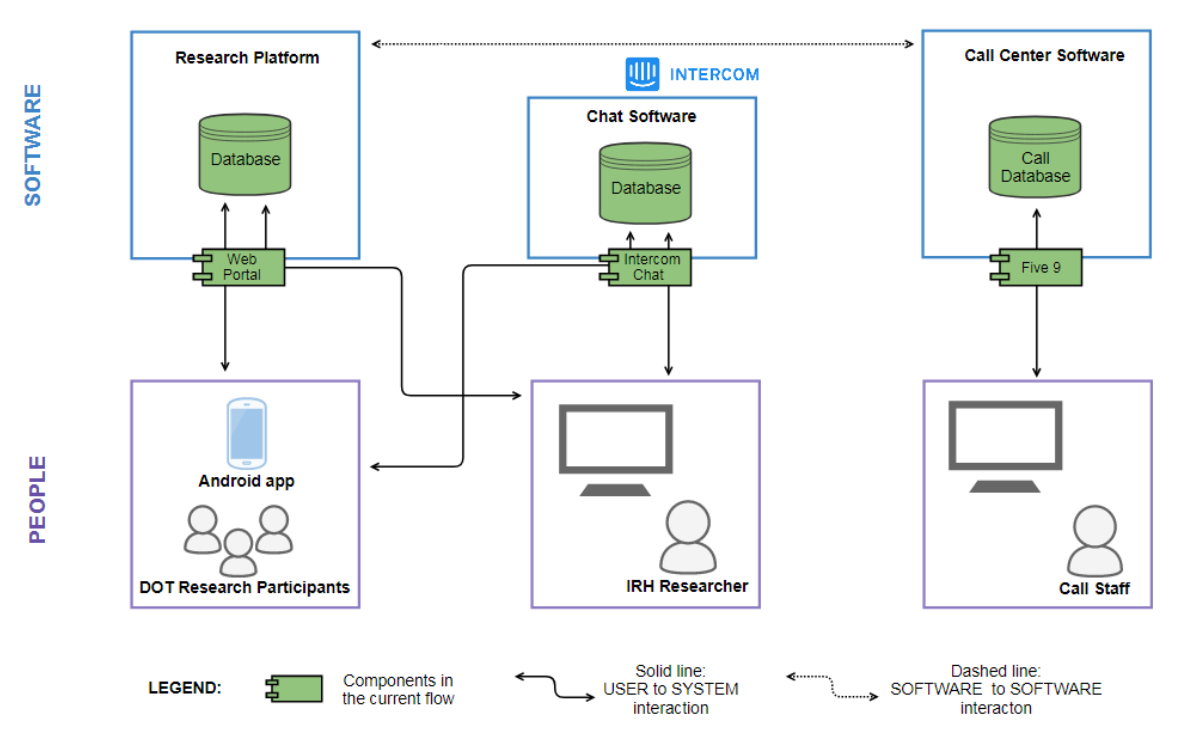
Figure 1. Proofmode’s framework for data collection adapted from Dot study